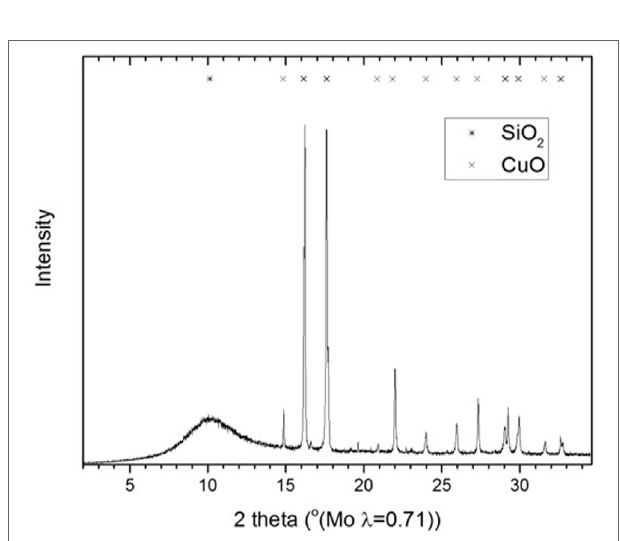
FigUre 9 | TEM image and an inserted electron diffraction of the calcined CuO/SiO 2 catalyst.